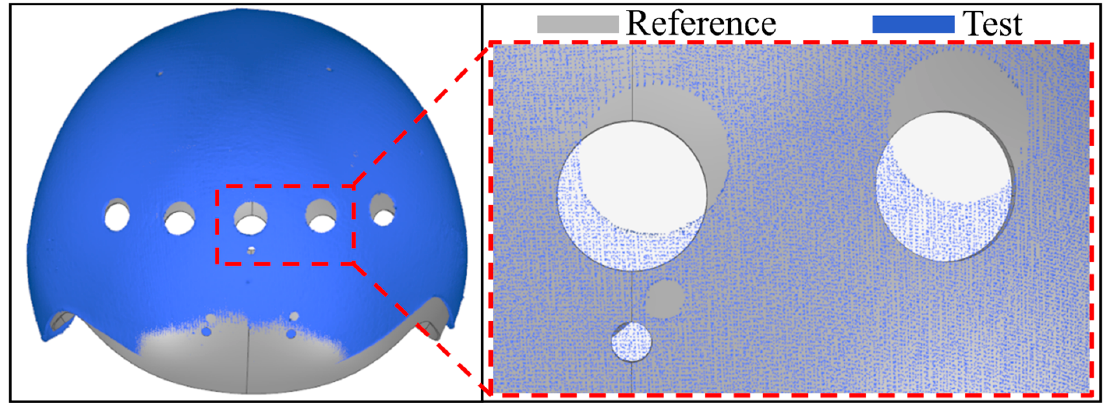
Figure 5. Alignment result based on ICP algorithm.